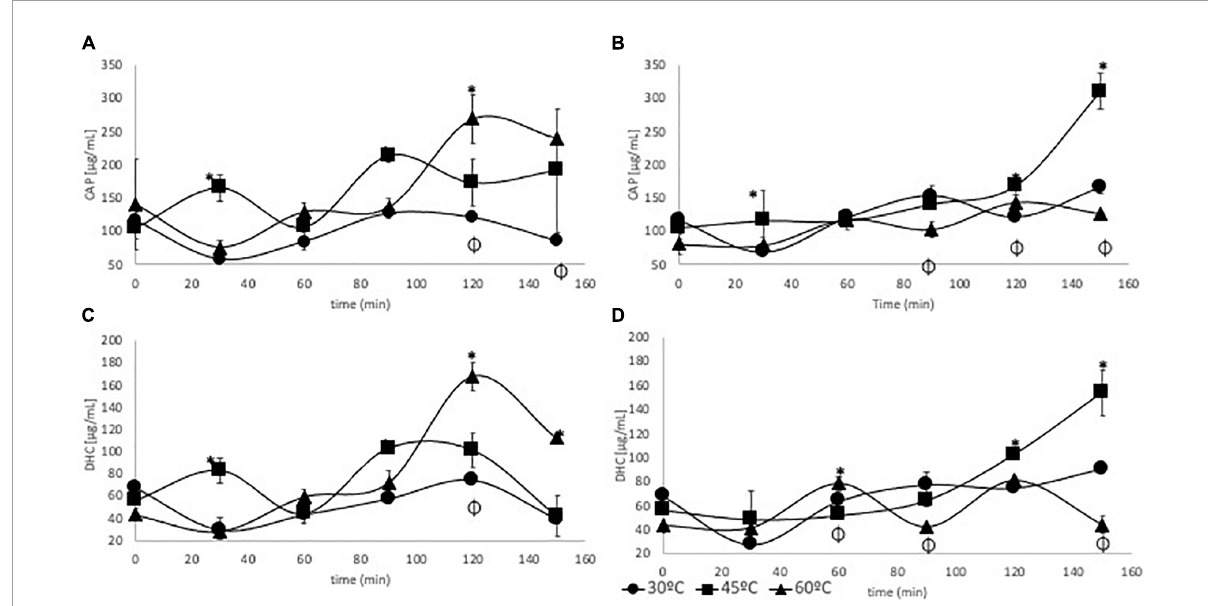
FIGURE3 Extraction kinetics of (A) CAP with an enzyme concentration of 2,500 UI/L, (B) CAP with an enzyme concentration of 250 UI/L, (C) DHC with an enzyme concentration of 2,500 UI/L, and (D) DHC with an enzyme concentration of 250 UI/L. ( ∗ ) Highest increase at each sampling time after Tukey statistical test, and ( φ ) lowest increase at each sampling time after Tukey statistical test.